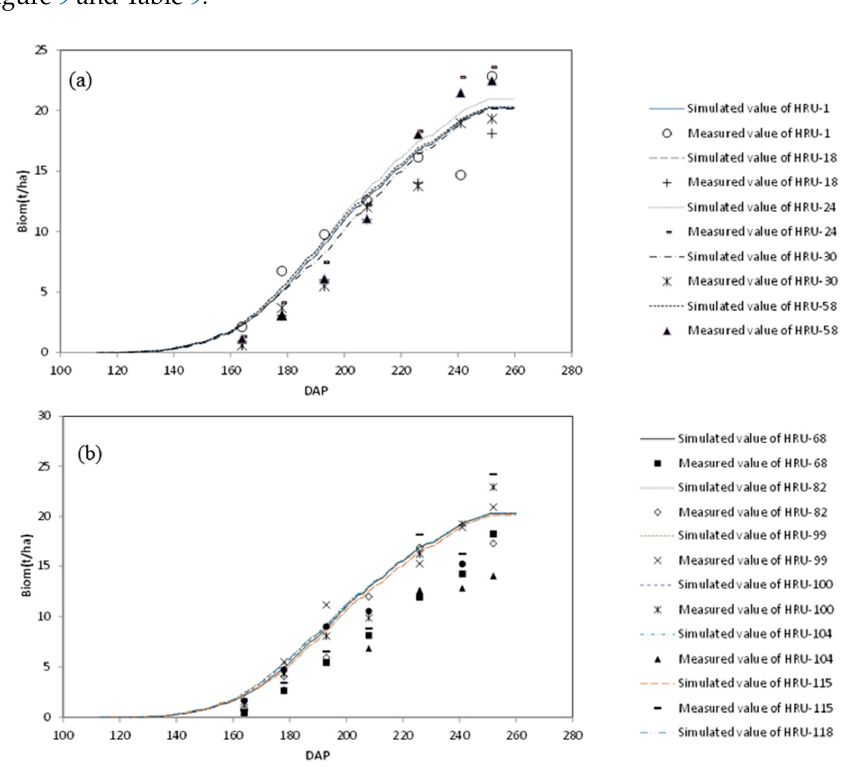
Figure 9. Typical variations in simulated and measured values of shoot dry matter (( a ) values for calibration; and ( b ) values for validation; DAP is day after planting). Table 9. Statistical parameters related to shoot dry matter in the calibration and validation phases.